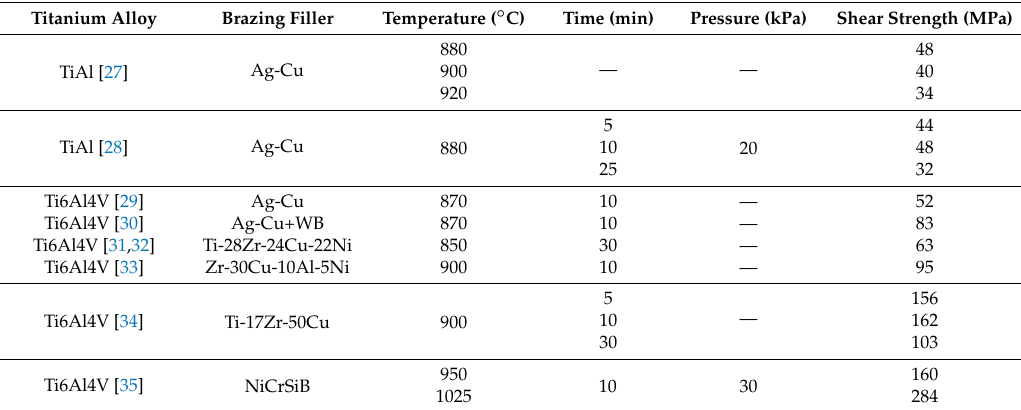
Table 2. Brazing conditions and shear strength values of titanium alloys and ZrO 2 joints. Titanium